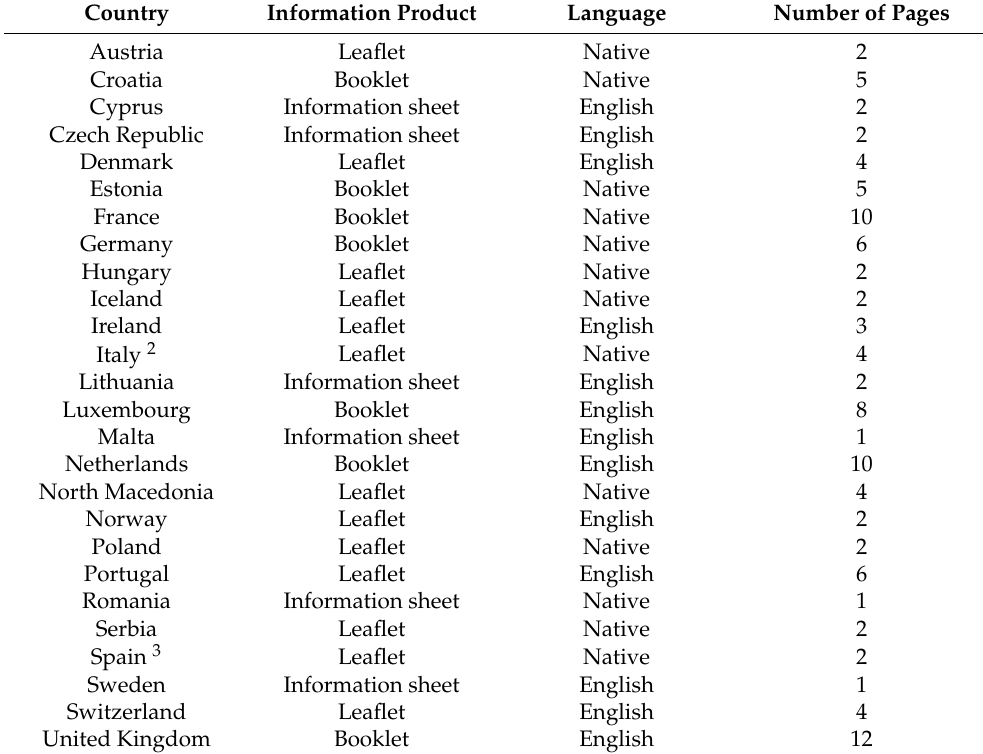
Table 2. Characteristics information products in different European countries.